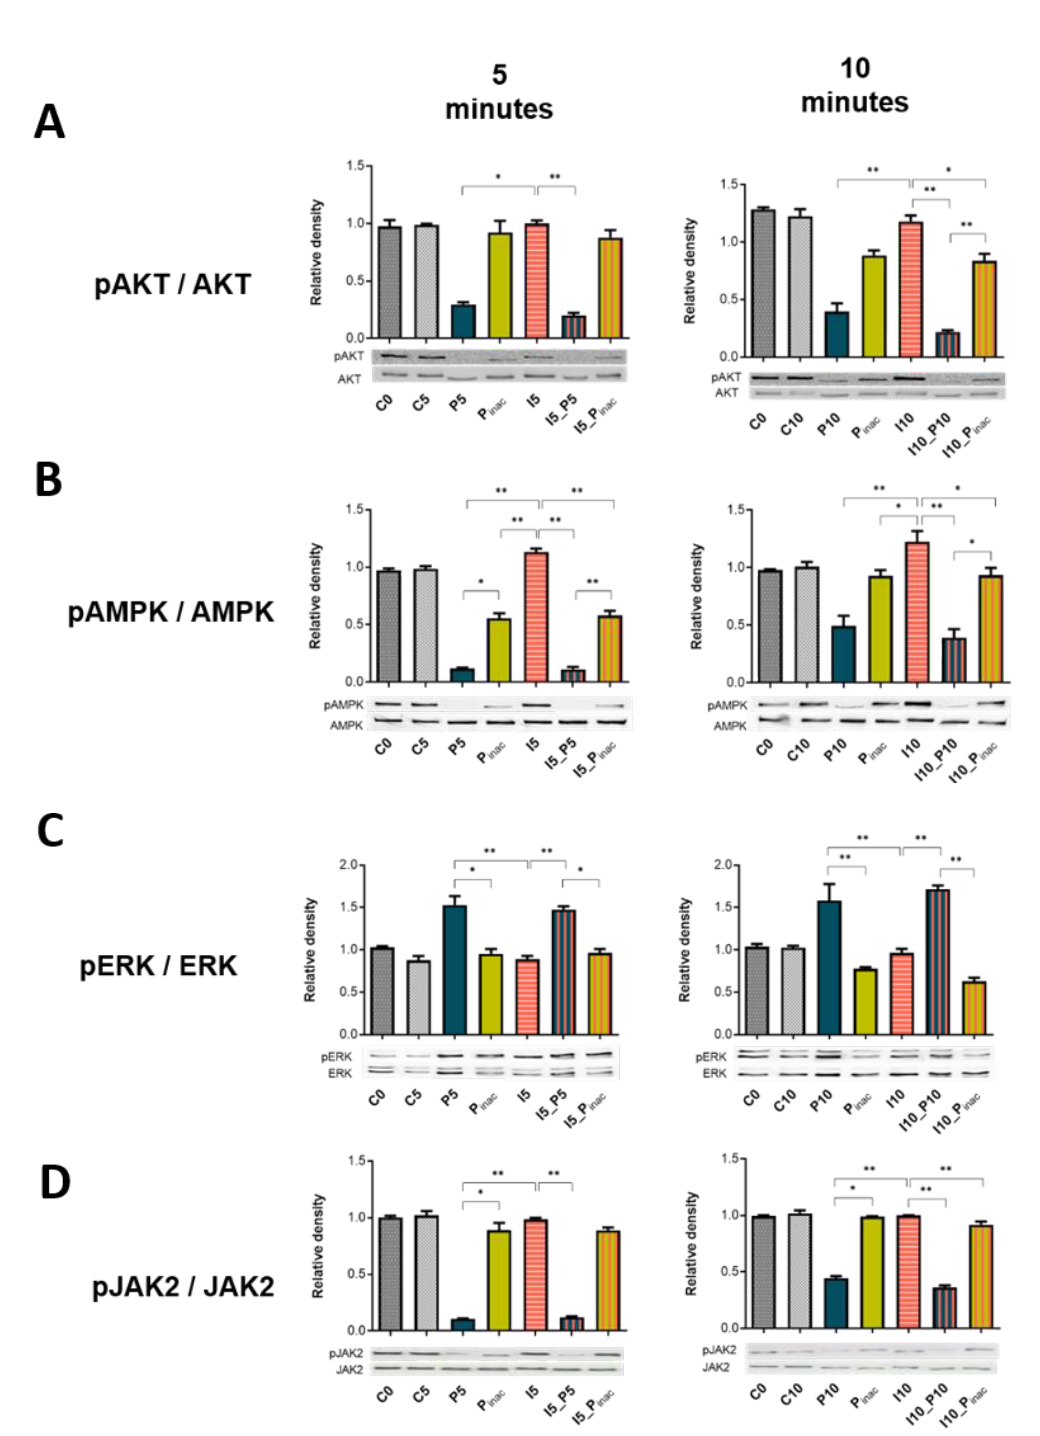
Figure 6. Western blots of phospho-AKT ( A ), phospho-AMPK ( B ), phospho-ERK1/2 ( C ), and phospho-JAK2 ( D ) in newborn pig tracheal cells infected with swIAV H1N2 in the absence or presence of PRRSV-1. Cells were infected at an MOI of 3 and harvested simultaneously at 5 and 10 min, so the results are representative of two independent experiments. C0, C5, and C10 stand for the cells from the non-infected conditions over 0, 5, and 10 min; P5, P10 and Pinac for cells stimulated with active or inactivated PRRSV-1 simultaneously for 5 and 10 min, while I5 and I10 stand for cells infected with swIAV H1N2 for 5 or 10 min. AKT, AMPK, ERK, and JAK2 are shown as loading controls and did not change with each condition over time. Mean values and standard deviations are represented, n = 3 wells per condition. Comparisons were carried out using a one-way ANOVA test and Tukey’s post-test after sorting the data by rank. Differences were considered significant when p < 0.05 (*) or p < 0.01